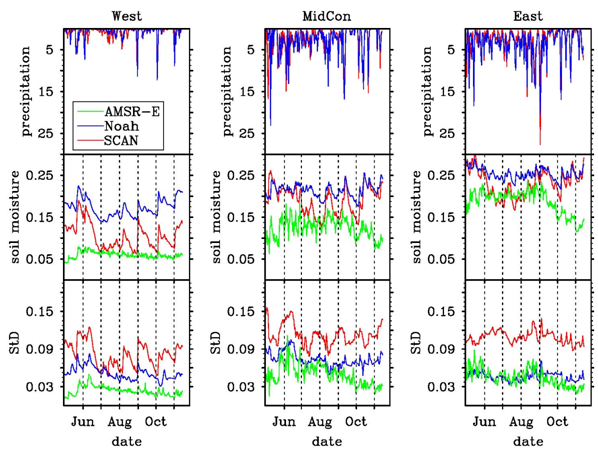
Fig. 4. Time series of daily (averaged over values at SCAN loca- tions) precipitation (mm), spatial mean soil moisture (cm 3 cm − 3 ) and soil moisture standard deviation (StD) in climate regions. Statis- tics of Noah and AMSR-E were calculated using data at SCAN lo-